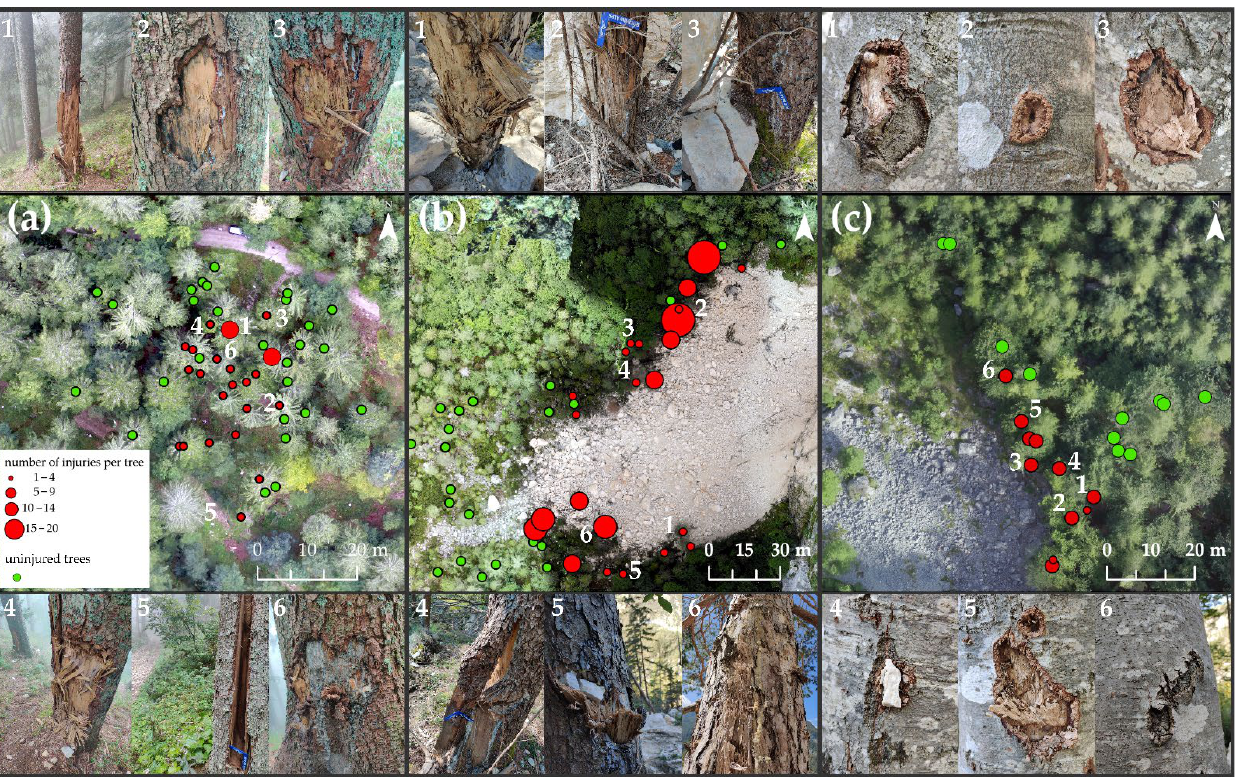
Figure 6. Locations of uninjured and injured trees with examples of injuries for each site ( a ) Jelovica, ( b ) Cerkev, and ( c ) Kekec. ( b ) Cerkev, and ( c ) Kekec.